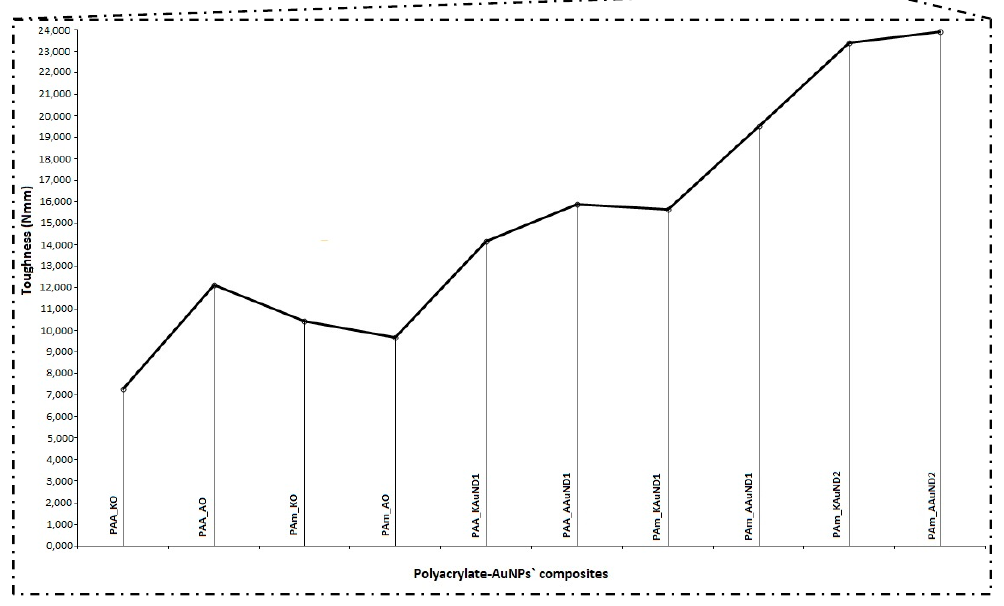
Materials 2019 , 12 , x FOR PEER REVIEW Figure 7. Mechanical properties (toughness) of control samples and polyacrylate-AuNPs’ composites.